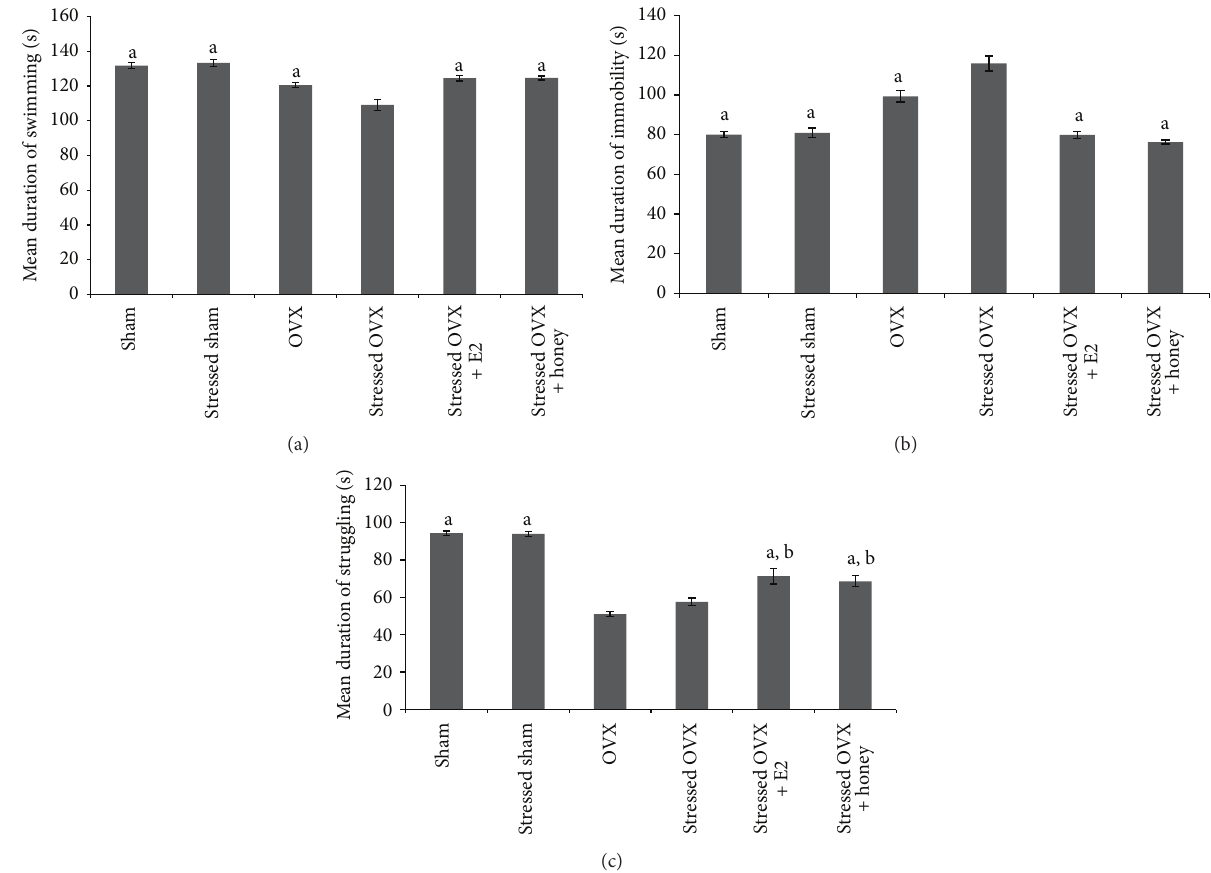
Figure1:EffectsofE2andTualanghoneytreatmentsondepressive-likebehaviour.(a)Swimmingtime(b)immobilitytime,and(c)struggling time/5 minutes. Each column represents the mean ± SEM of 10 rats; a 𝑃 < 0.05 compared with the stressed OVX group; b 𝑃 < 0.05 compared with the sham group.